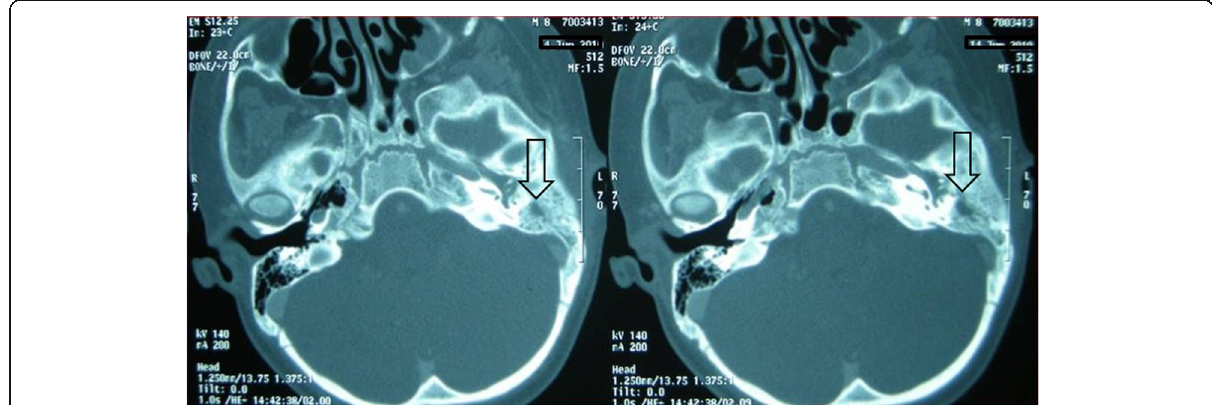
Fig. 2 Axial section of temporal CT: soft tissue surrounding ossicular structures in mastoid cells and middle ear cavity on the left ear, arrows show